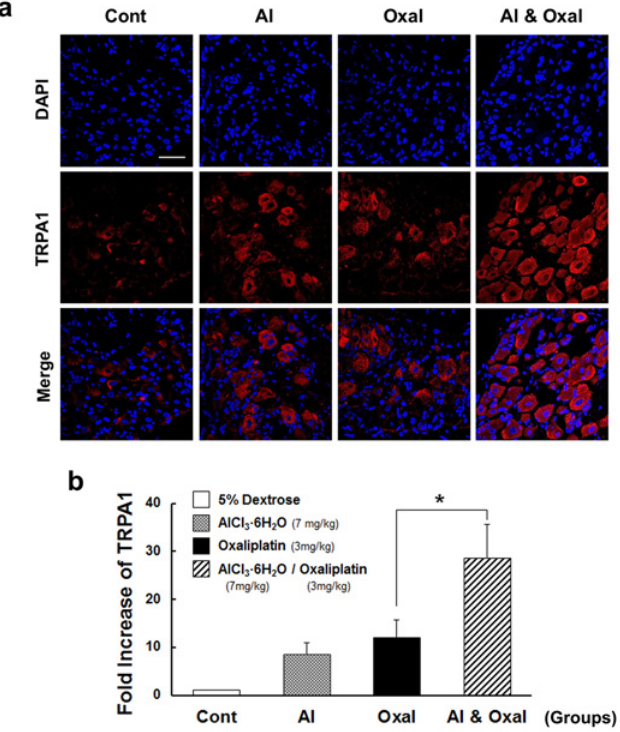
Fig 7. TRPA1 mRNA and protein expression in DRG of mice after combination treatment with oxaliplatin and aluminum chloride. DRG tissues from Cont (5% dextrose), Al (aluminum chloride; AlCl 3 (cid:1) 6H 2 O, 7 mg/kg; equivalent 0.78 mg/kg of elemental Al), Oxal (oxaliplatin, 3 mg/kg), and Al & Oxal (aluminum chloride 7 mg/kg and oxaliplatin 3 mg/kg) groups were harvested at 6 days after the final infusion treatment. (a) Immunofluorescent staining for protein expression was conducted on DRG cryo-sections with anti-TRPA1. Nuclei were stained with DAPI (blue) and visualized by confocal scanning microscopy. The TRPA1 (red) protein level was significantly higher in DRGs from the Al & Oxal groups compared with the Al or Oxal groups. (b) The relative ratio of TRPA1 mRNA measured by quantitative real-time PCR was significantly higher in the DRG from the Al & Oxal compared with that of Al or Oxal. TRPA1 levels are expressed as fold changes after normalizing to 28S RNA. The experiment was conducted in triplicate. Values are expressed as the mean ± SEM ( n = 10 per group). * p < 0.05 compared with the oxaliplatin group. Scale bar = 40 μ m for all